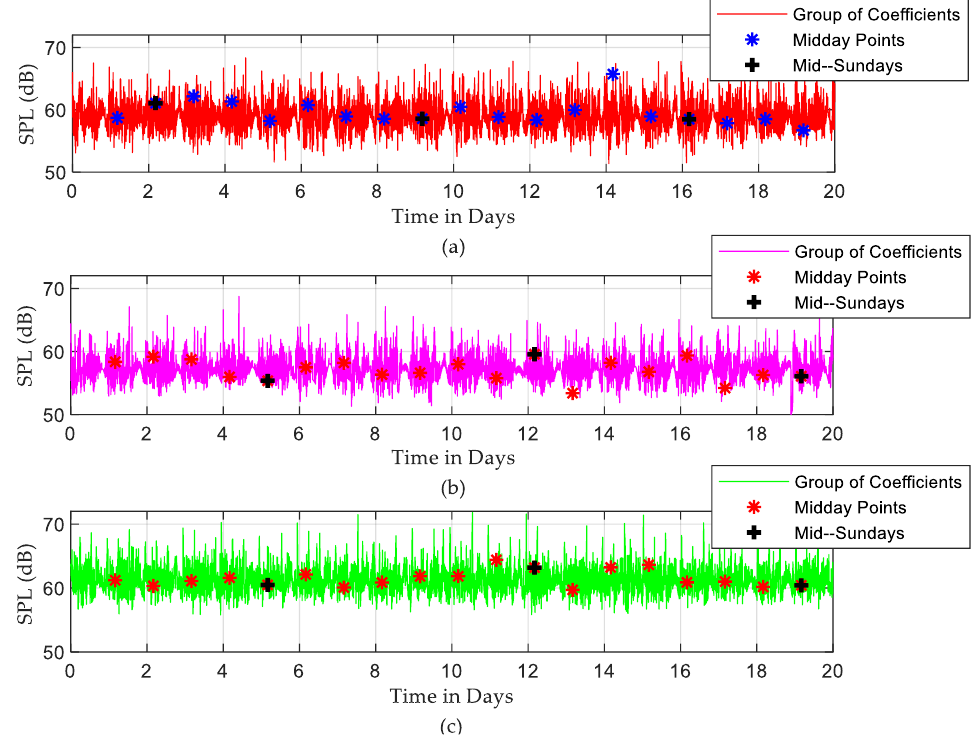
Figure 9. Random noise over 20 days, reconstructed SPL time series by employing IFFT to the rest of the coefficients: ( a ) ICU1, ( b ) ICU2, and ( c ) ICU3.